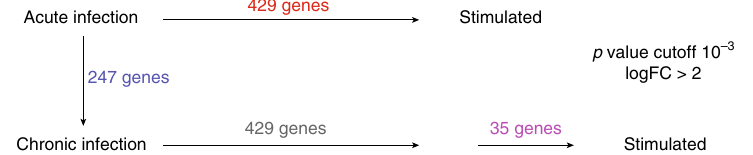
Fig. 1 Transcriptional pro fi ling of functional or exhausted P14 cells with or without restimulation. P14 cells were adoptively transferred into mice 1 day prior high or low-dose LCMV clone 13 infection. Animals were sacri fi ced after 14 days. CD8 + P14 cells were stimulated with anti-CD3 and anti-CD28 for 4h. RNA was extracted and sequenced. a Heatmap of the 200 most variable gene pro fi les was generated using hierarchical clustering ( k = 4). Selected genes are annotated. Heatmap colors indicate normalized gene expression ranging from high (red) to low (blue). Gene color highlights differentially expressed genes between groups indicated in b . b Number of differentially expressed genes between the conditions are indicated. The nested effect model disentangles the effect of chronic infection and stimulation and contains an interaction term for stimulation in chronic infection. Color code of gene names indicates the group of the differential expression analysis (see Methods for details). Data from one experiment are shown. Source data are provided as a Source Data